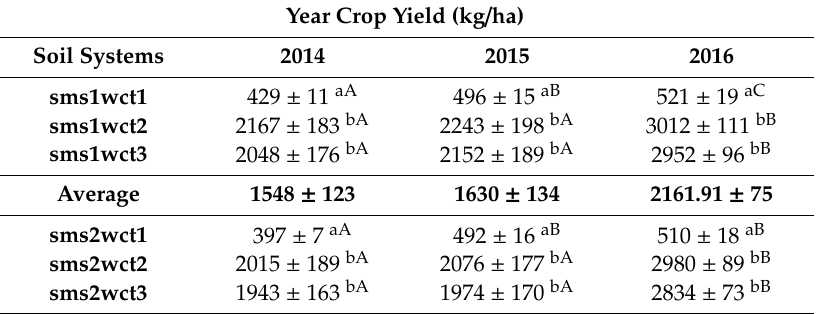
Table A2. The e ff ect of soil tillage systems on soybean yield at the experimental site 2014–2016. Di ff erent lowercase letters indicate significant di ff erences between the means of the same soil tillage systems in the same year of field, while capital letters indicate significant di ff erences between the means of di ff erent years and same soil tillage systems according to Tukey’s HSD test ( p ≤